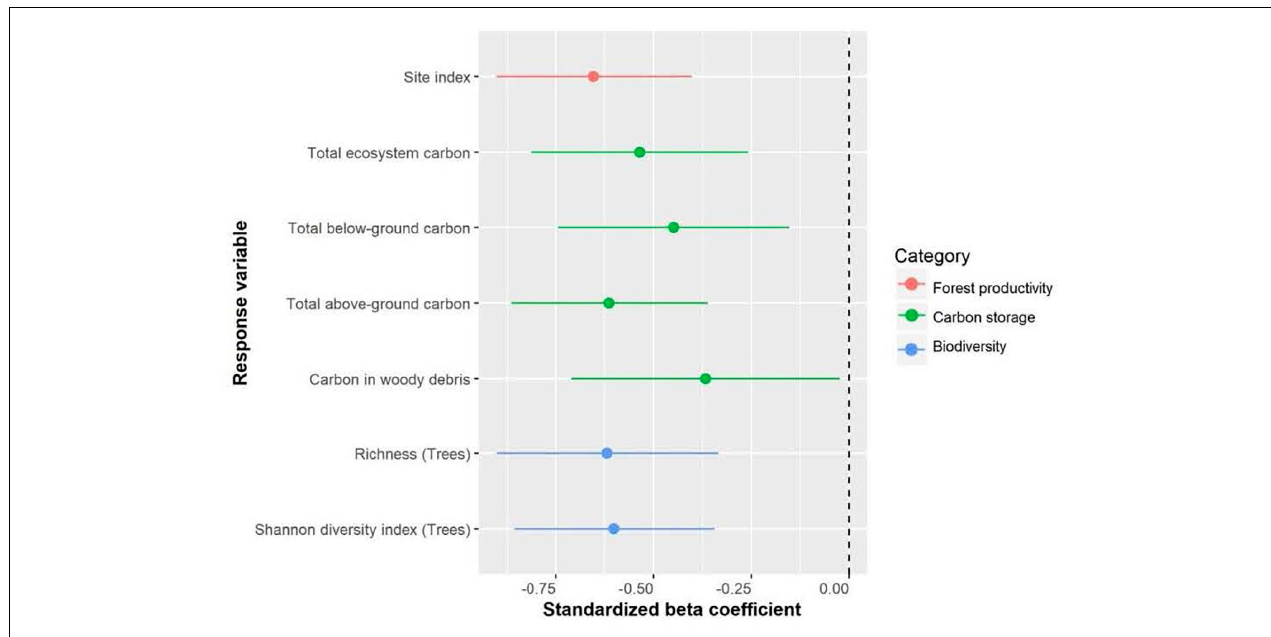
FIGURE 2 | Effect of annual heat moisture index (AHM, 1981-2010, calculated as (mean annual temperature + 10)/(mean annual precipitation/1000), used as an aridity index) on site index, carbon storage and biodiversity of Douglas-fir-dominated forests. Circles indicate average estimates and lines indicate 95% confidence intervals.